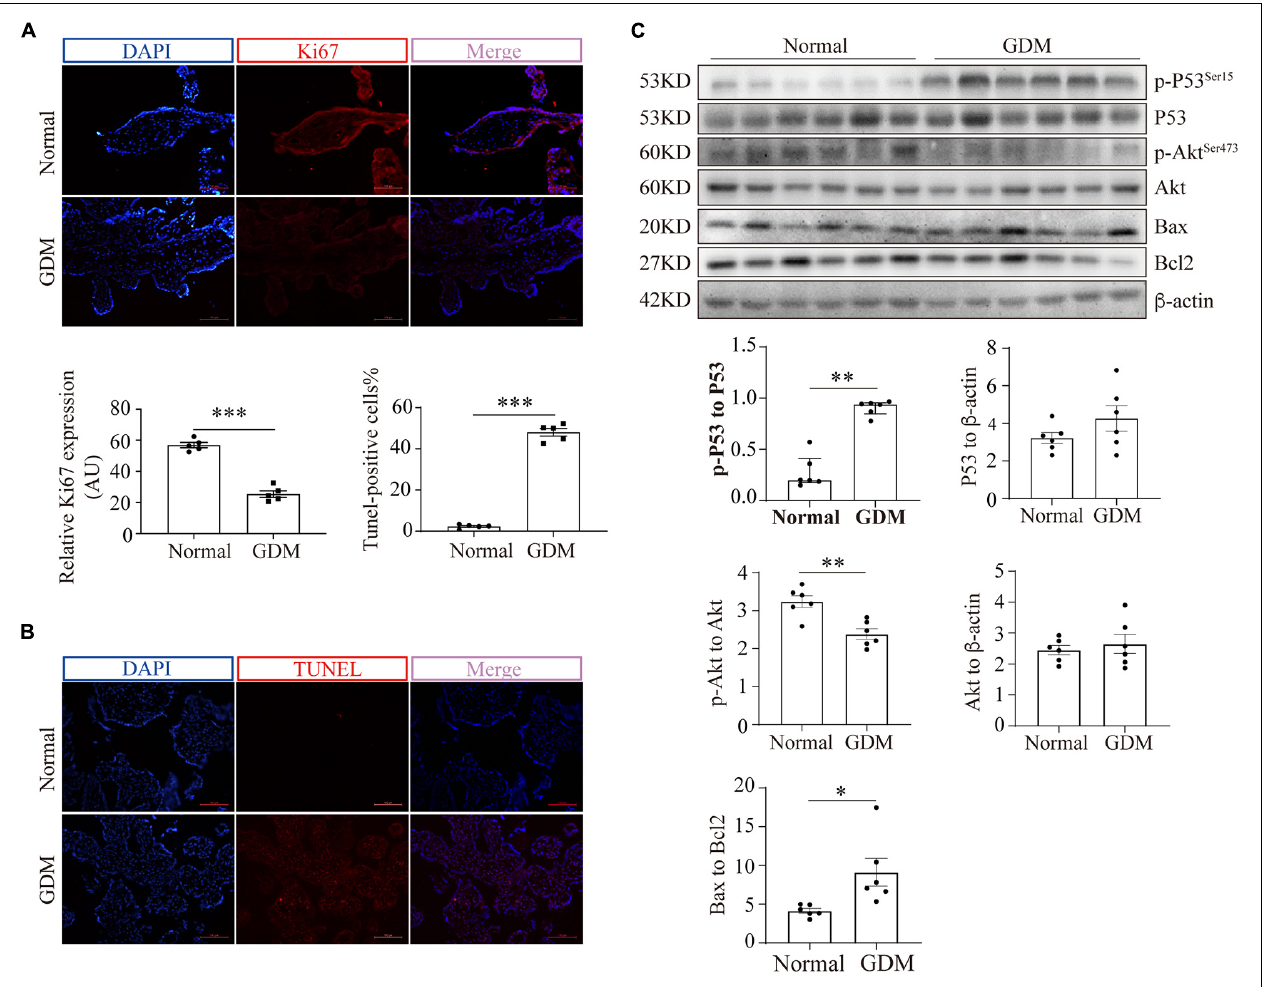
FIGURE 2 | Cell viability is compromised in GDM-complicated human placentas. (A) IF staining of Ki67. Bar: 100 µ m, n = 5. The fluorescence was measured as the intensity per unit area, and the average intensity was calculated for analysis. (B) TUNEL staining of normal and GDM-complicated human placentas. Bar: 100 µ m, n = 5; the percentage of TUNEL-positive cells represents the ratio of the number of TUNEL-positive stained cells to the total cell number. (C) p-p53, p53, p-Akt, Akt, Bax and Bcl2 protein levels in GDM-complicated and normal placentas. n = 6. The data that are presented as the means ± SEMs are annotated in normal font, and Student’s t -test was used between two groups. The data presented as the medians (IQRs) are shown in bold font and Mann-Whitney test was used between two groups. ∗ p < 0.05, ∗∗ p < 0.01, and ∗∗∗ p <